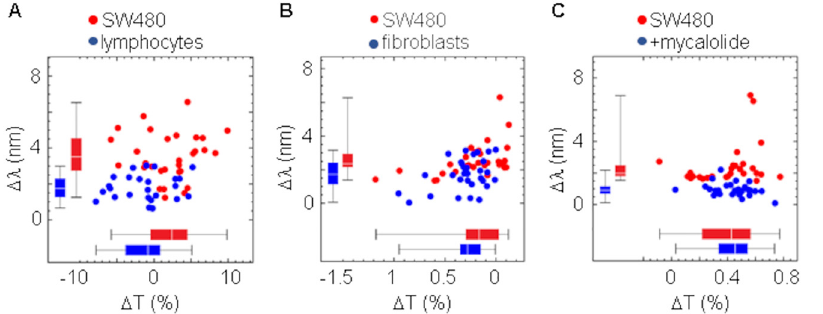
Figure 9: Actin cortex plays a major role in the spectral differences between SW480 cells and normal primary cells. (A) Spectral shift and change in transmittance comparing SW480 and peripheral blood lymphocytes. Threshold was set to 2.4 nm and sensitivity (83%) and speci fi city (84%) were determined. (B) Spectral shift and change in transmittance comparing SW480 and epidermal fi broblasts. Threshold was set to 2.2 nm and sensitivity (67%) and speci fi city (70%) were determined. (C) SW480 cells were incubated with actin depolarizing agentmycalolideB(5 μ Mfor1 hat 37 ° C)andthenspectralshift andchange intransmittanceweredeterminedinindividual cells eitheruntreated or treated with mycalolideB. Thresholdwas set to 1.5nm and sensitivity (100%)and speci fi city (89%)weredetermined.